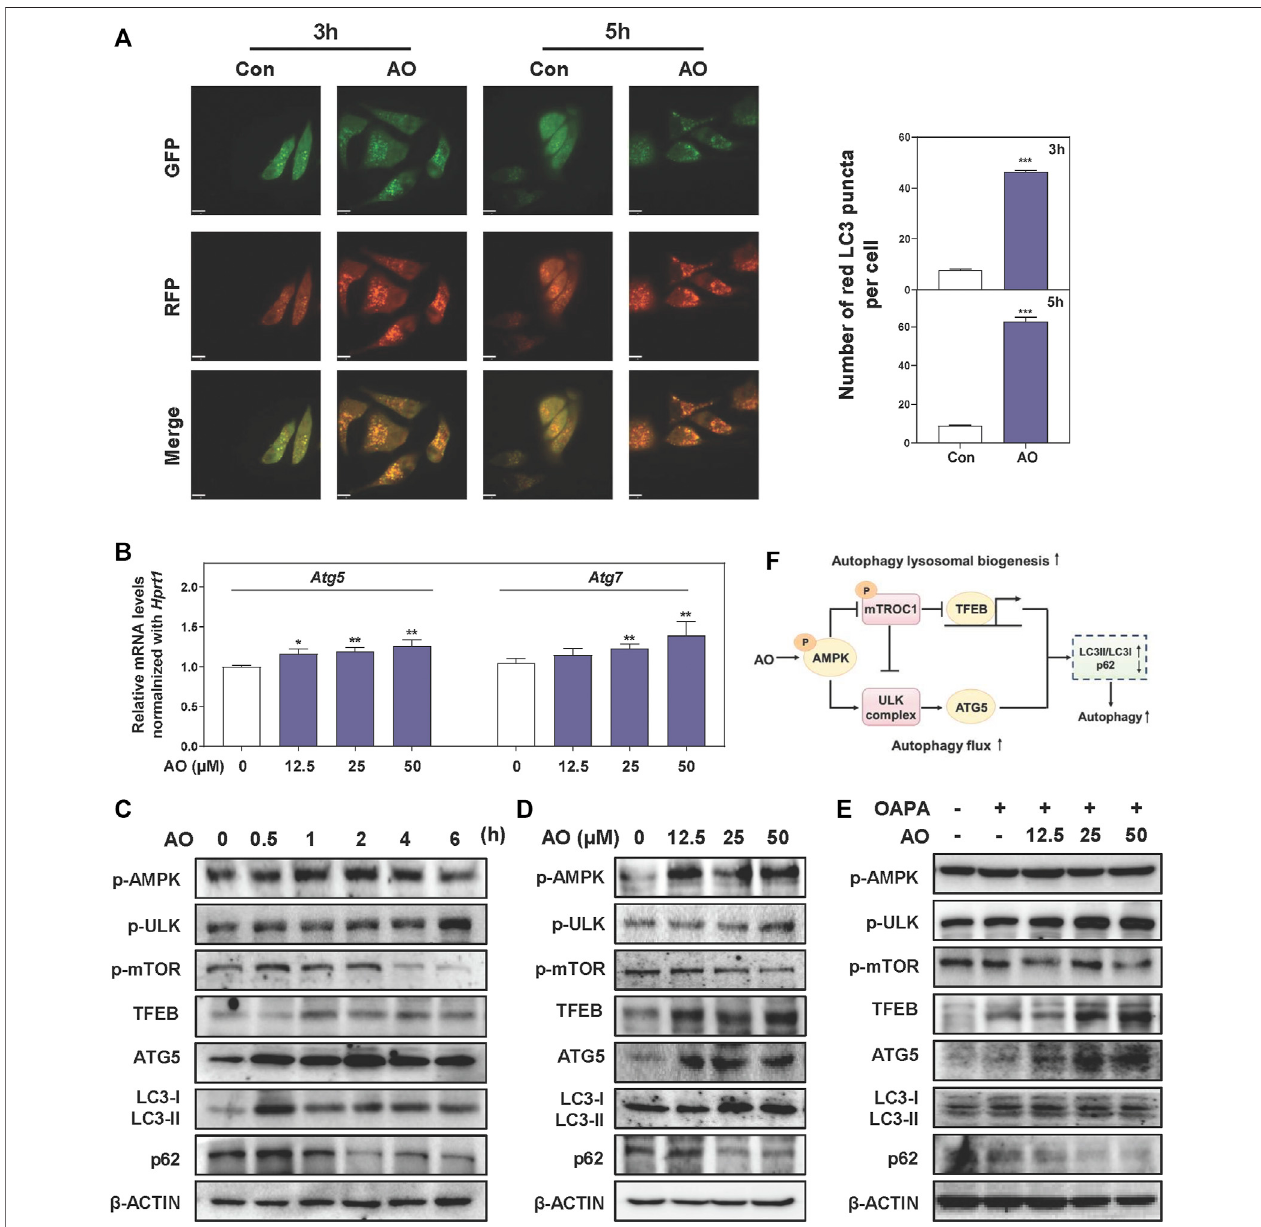
FIGURE4| AOrapidlytriggersautophagy fl uxinhepatocytes (A) MPHsweretreatedwithAO(25 μ M)for3and5 h.Themeannumbersofredpunctarepresenting autolysosomeswereplotted (B) RelativemRNAlevelsof Atg5 and Atg7 inMPHsweredetermined byqPCRandnormalized using Hprt1 asaninternalcontrol (C) MPHs were treated with AO (25 μ M) at different time points (D and E) MPHs were treated with different concentrations of AO with or without OAPA (C, D and E) The protein levels of p-AMPK, p-ULK, p-mTOR, TFEB, ATG5, LC3-II/LC3-I and p62 in MPHs were determined by western blot using β -ACTIN as a loading control (F) Schematic diagram that linked AO with the regulation of autophagy. Statistical signi fi cance: * p < 0.05, ** p < 0.01, *** p < 0.001, compared with control group (n (cid:1) 3).